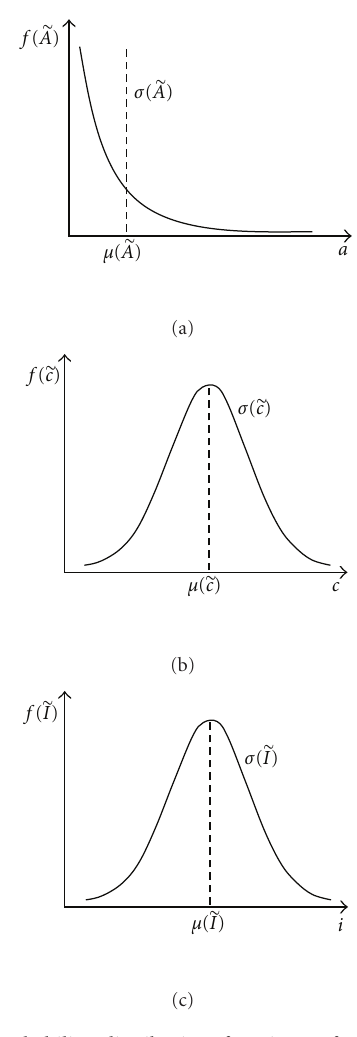
Figure 1: Probability distribution functions of one set of the stochastic input parameters (cid:2) A , (cid:2) c , and (cid:2) I